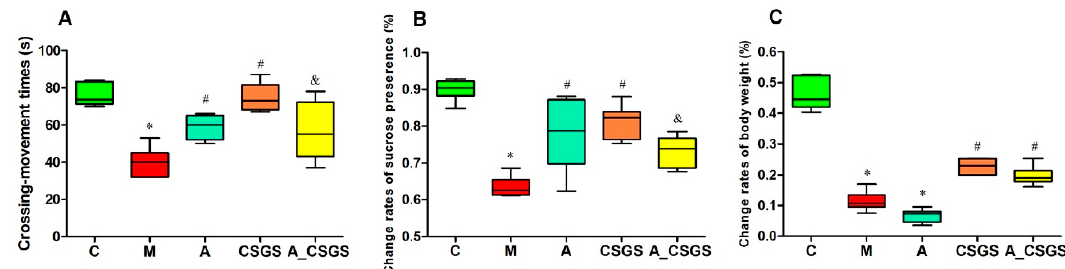
Figure 1. The results of behavioral tests and body weight in di ff erent treatment groups of rats: ( A ) the number of rearing and crossing; ( B ) the sucrose preference; ( C ) the body weight changes. C: control group; M: chronic variable stress (CVS) model group; A: Antibiotic treated group with CVS; CSGS: Chaihu-Shu-Gan-San (CSGS) treated group; A_CSGS: Antibiotic + CSGS treated group. * p < 0.05 vs. C; # p < 0.05 vs. M; & p < 0.05 vs. CSGS. The post hoc analysis of variance (ANOVA) used for statistical analysis and data with different superscript letters are significantly different.